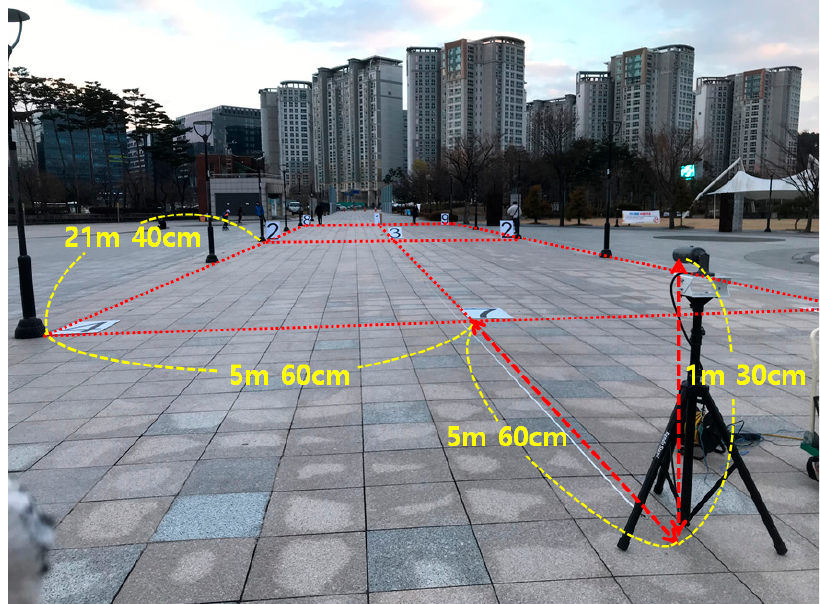
Figure 8. Measured information of floor plan using the world coordinate